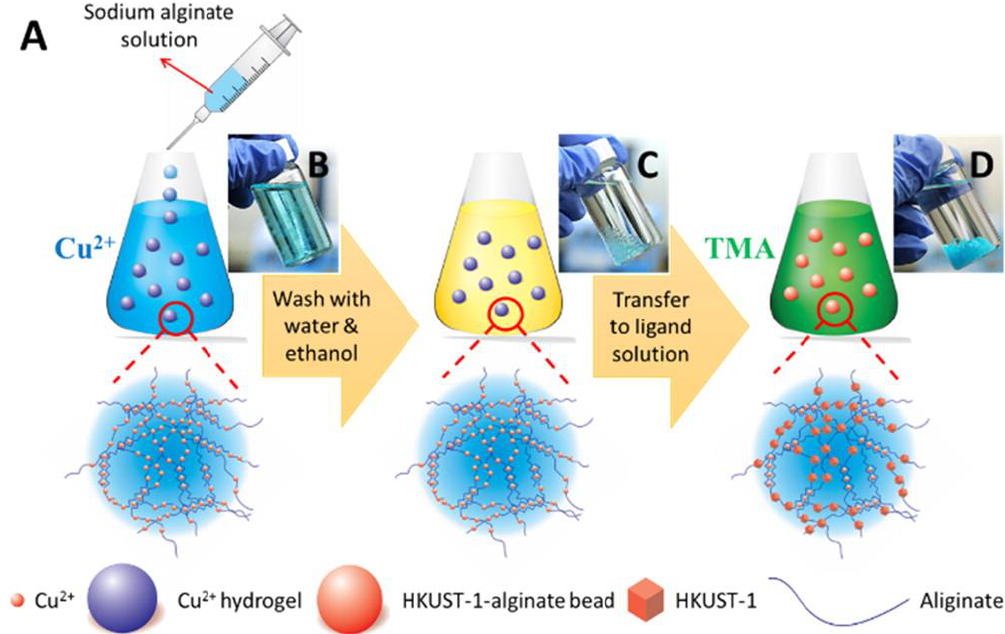
Figure 8. ( A ) Schematic of the preparation of the MOF–alginate composite. Photographs of ( B ) alginate hydrogels cross-linked by Cu 2+ right after the addition of a sodium alginate aqueous solution to a Cu 2+ aqueous solution, ( C ) alginate hydrogels cross-linked by Cu 2+ after being washed with water and ethanol, and ( D ) HKUST-1–alginate hydrogels [159]. Reprinted with permission from Ref. [159]. Copyright American Chemical Society, 2016.